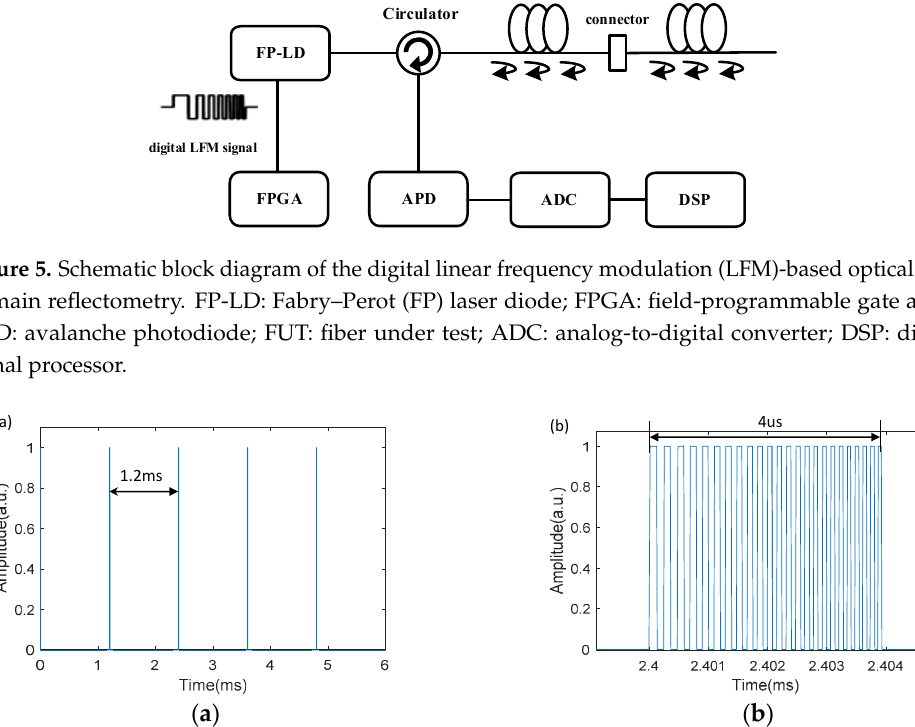
Figure 6. Periodic digital linear frequency modulation (LFM) signal. ( a ) Time-domain waveform, with a pulse period of 1.2 ms, ( b ) zoom-in of the digital LFM signal in (a), with a pulse width of 4 us and a sweep frequency ranging from 4 MHz to 8 MHz ( B = 4 MHz).